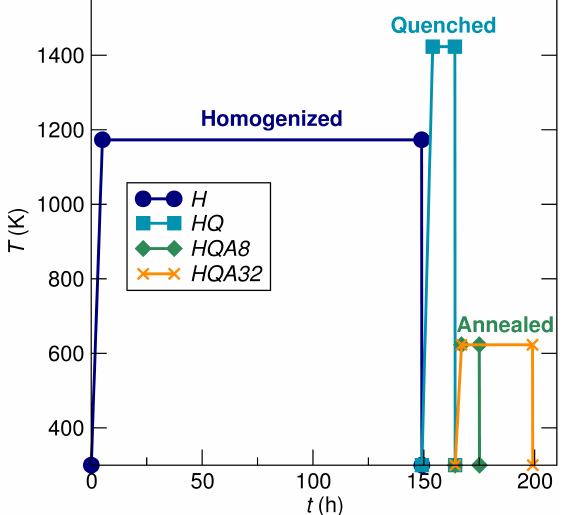
Figure 2. Nature of heat treatments employed in this study. Four samples were prepared: H , HQ , HQA8 and HQA32 ( H , homogenized; Q , quenched; A , annealed). With the exception of the final annealing for HQA8 and HQA32 , heat treatments were applied to samples